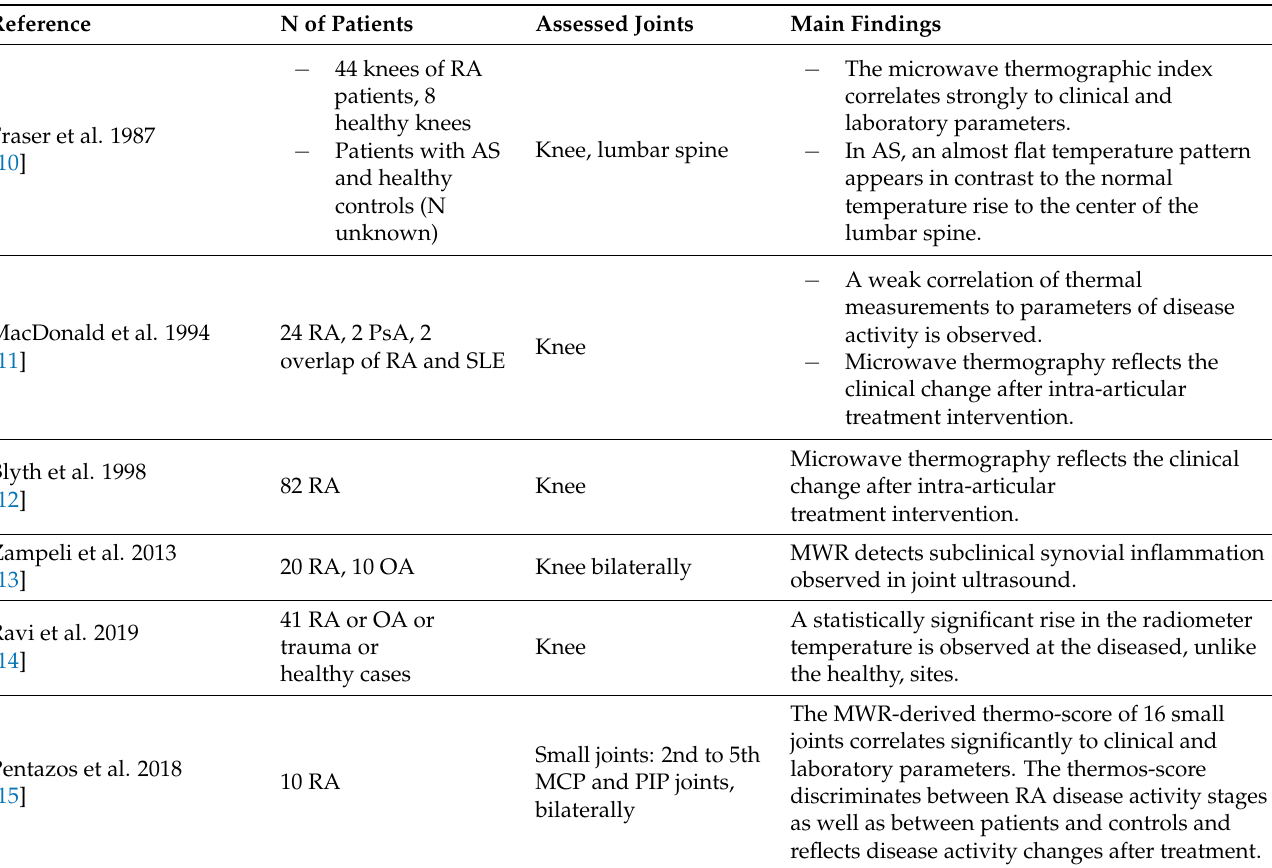
Table 1. Published evidence on the use of microwave radiometry for the assessment of inflammatory arthritis and low back